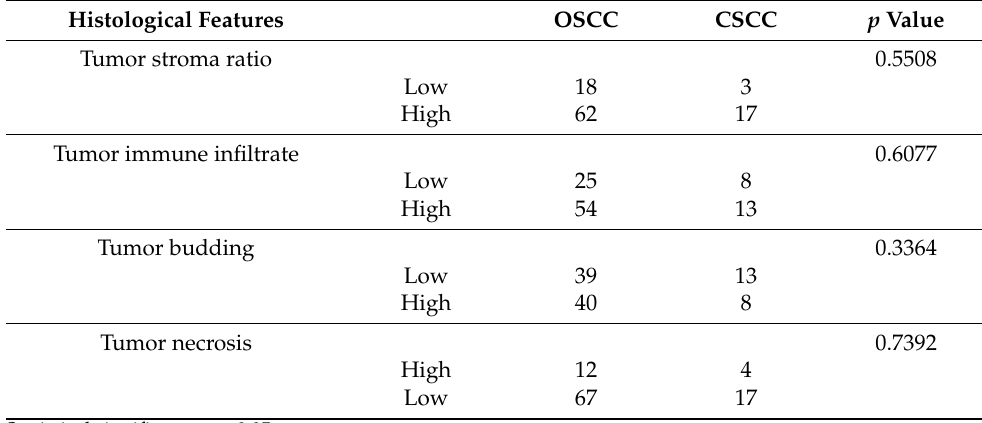
Table 3. Assessment of histological features in relation to SCC